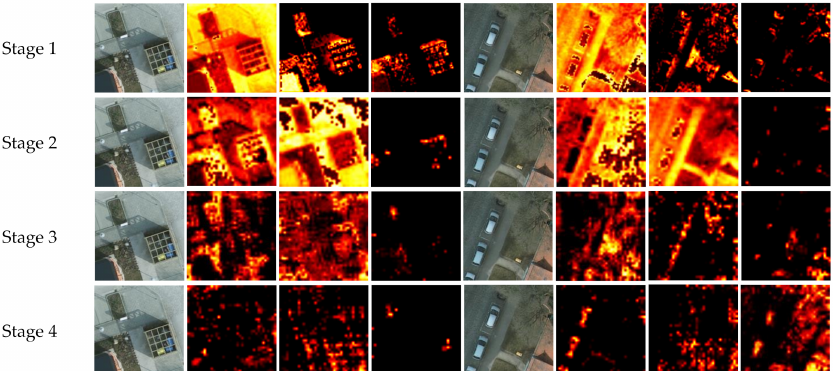
Figure 3. Feature maps output by each stage in the ResNeSt-50. The second and the sixth columns are original orthophotos (TOP); each row shows feature maps selected from a specific stage. Feature maps of stage 2, stage 3, and stage 4 (38 × 38) are unsampled to the same size as stage 1 (75 × 75).